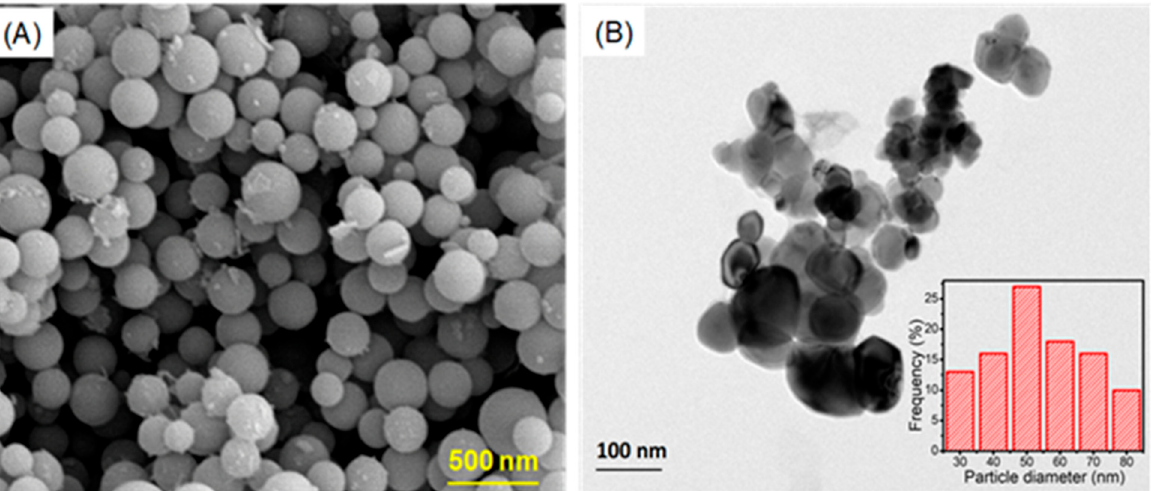
Figure 3. ( A ). SEM image of Ca − AgNPs synthesized from Cassia auriculate. ( B ). TEM images showing the sharper and size of the Ca − AgNPs. Inset: histogram showing the Ca − AgNPs particle size distribution.